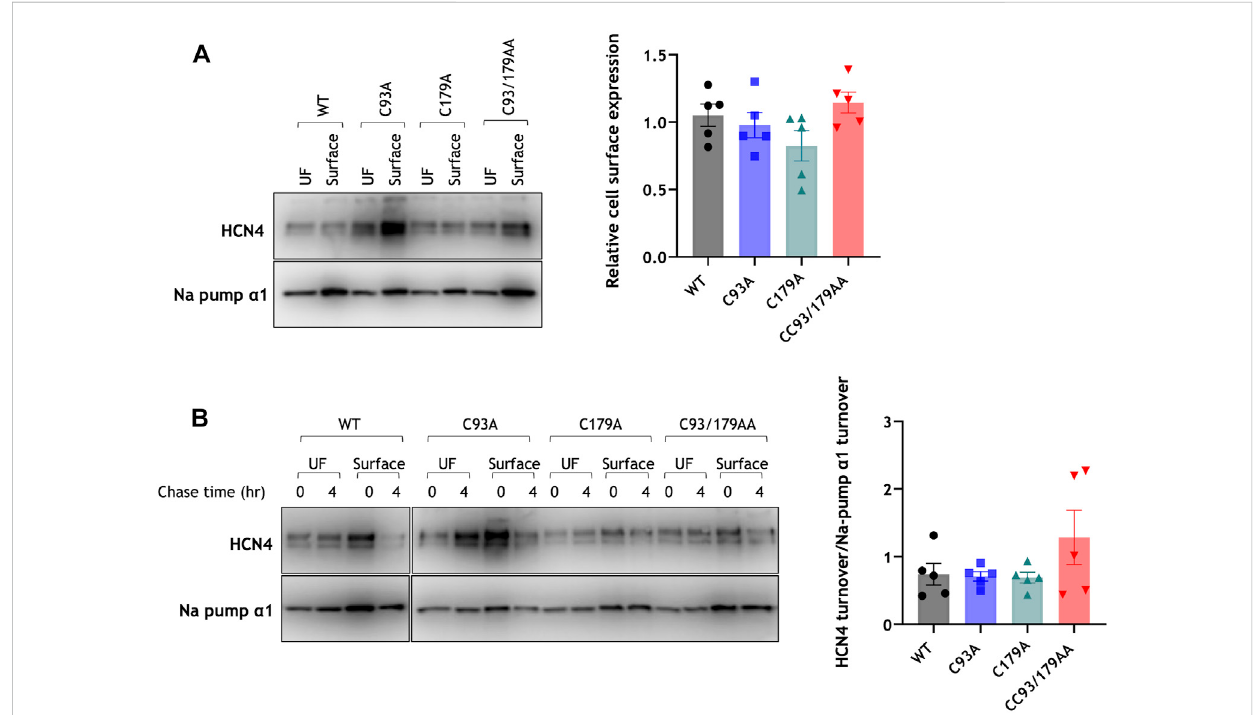
Palmitoylation and HCN4 traf fi cking. (A) Surface membrane proteins were prepared from stably transfected 293T cells using membrane- impermeable biotinylation reagents and immunoblotted alongside their corresponding unfractionated cell lysate. The plasma membrane